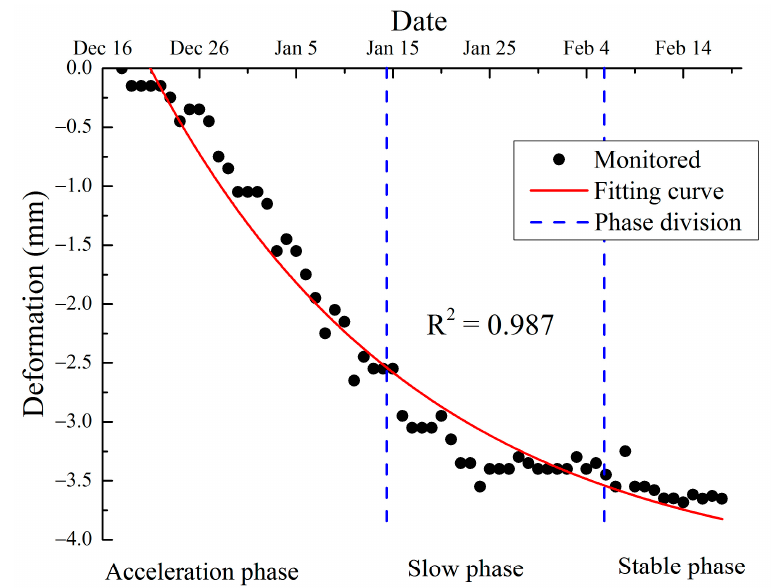
Figure 9. Velocity of the deformation of the ground surface.